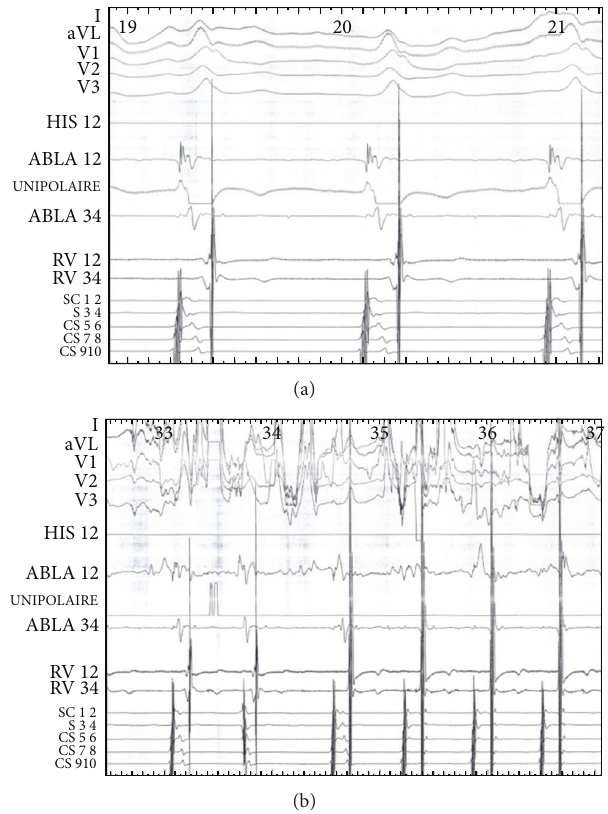
Figure 7: (a) Electrophysiology signal before the ablation. (b) The distal coronary sinus signal showed a separated ventricular signal from atria signal during ablation. The successful left accessory bypass ablation